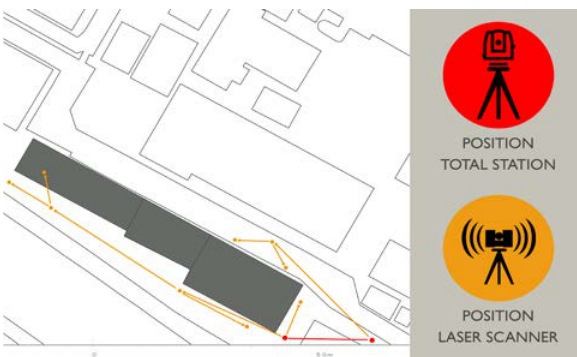
Figure 8: External survey project (building